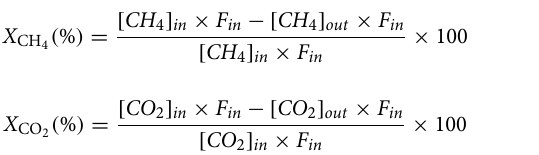
rate of 400 ml/min, corresponding to GHSV = 48,000 ml/g-h. During the reaction, the gas composition of the outlet stream was examined every 10 min using Gas chromatograph (TCD, Shimadzu, GC-2014). The volumet- ric flow rate of the inlet and outlet streams was controlled and calibrated by a mass flow controller (HORRIBA METRON, S48-32HMMT) and a soap bubble meter, respectively. After 3 h of the reaction time, the biogas was switched to the He flow at 50 ml/min to cool down the reactor to room temperature. The spent catalyst with deposited carbon was then weighed and collected in a desiccator for further characterization. Product analysis. The catalytic performance of the bimetallic and trimetallic catalysts in the integration of dry reforming.